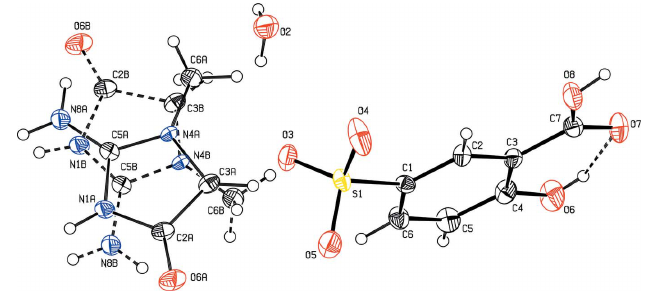
Figure 1 The molecular structure of the title molecular salt, with atom labelling and 30% probability displacement ellipsoids. The minor component in the cation is shown with dashed bonds. The intramolecular hydrogen bond in the anion is shown with a dashed